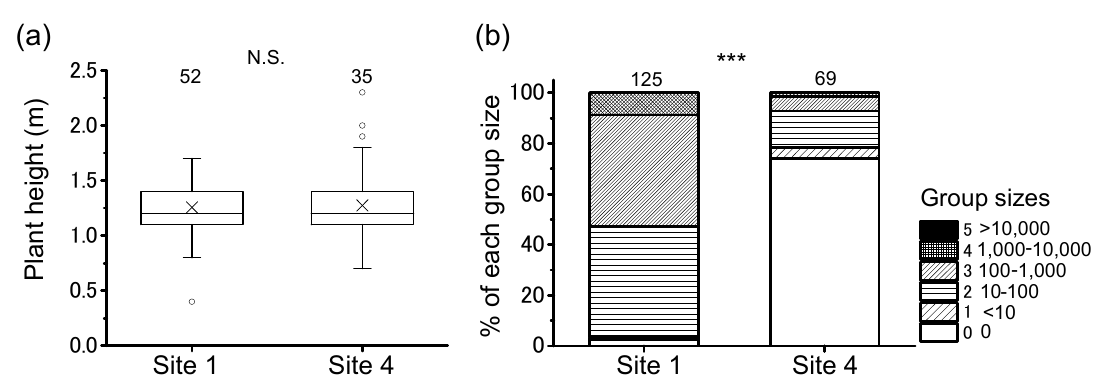
Figure 6. Height of Euphorbia balsamifera plants ( a ) and the percentage of E. balsamifera plants roosted by each group size of Schistocerca gregaria swarms ( b ) at a site without trees (Site 1) and one with trees (Site 4). Each box plot displays the median value with the ends of the boxes representing the 25th and 75th percentiles and the ends of the lines representing the 10th and 90th percentile values. Crosses indicate mean values and open circles are outliers. N.S. indicates no significant di ff erences at p > 0.05 according to a Wilcoxon rank sum test. Numbers in figures indicate sample sizes. ***, significant di ff erences between the two groups ( χ 2 -test, p < 0.001).